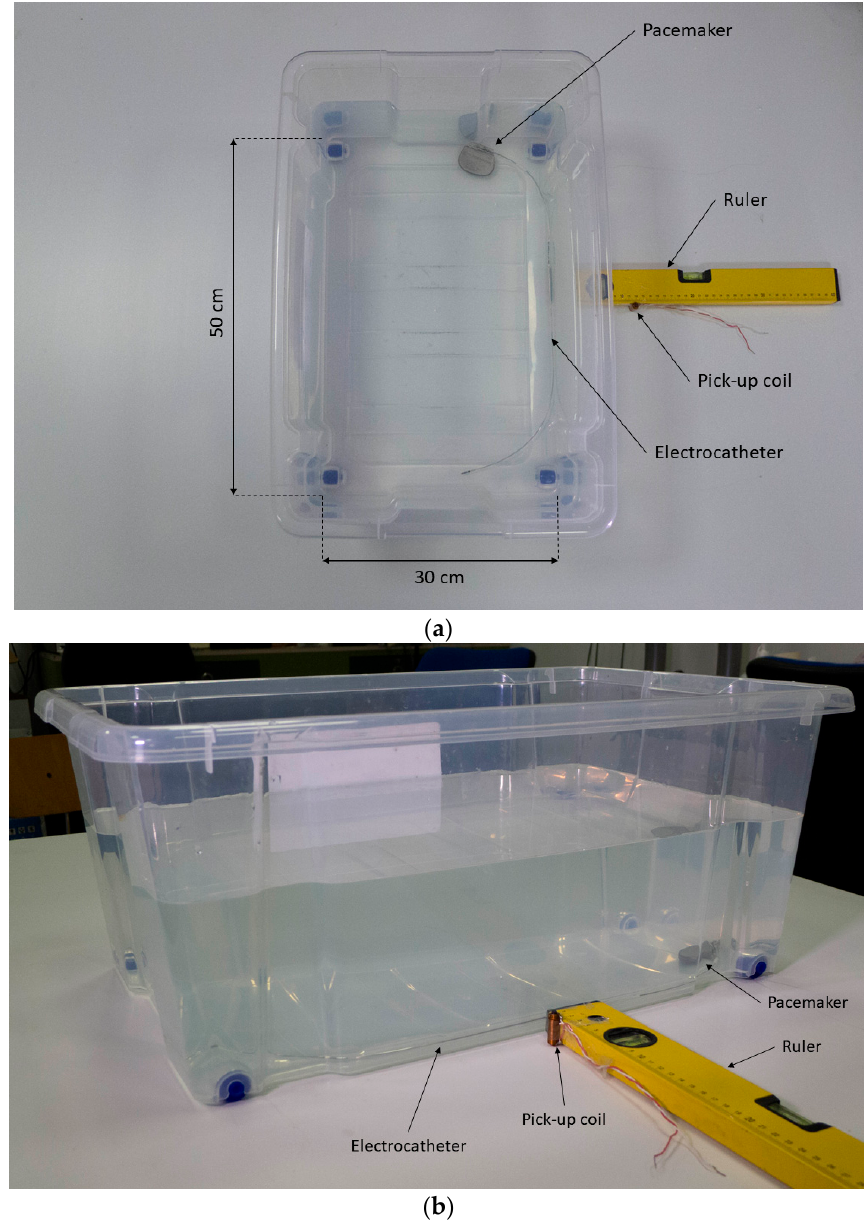
Figure 5. Measurement setup. ( a ) Top view; ( b ) side view.